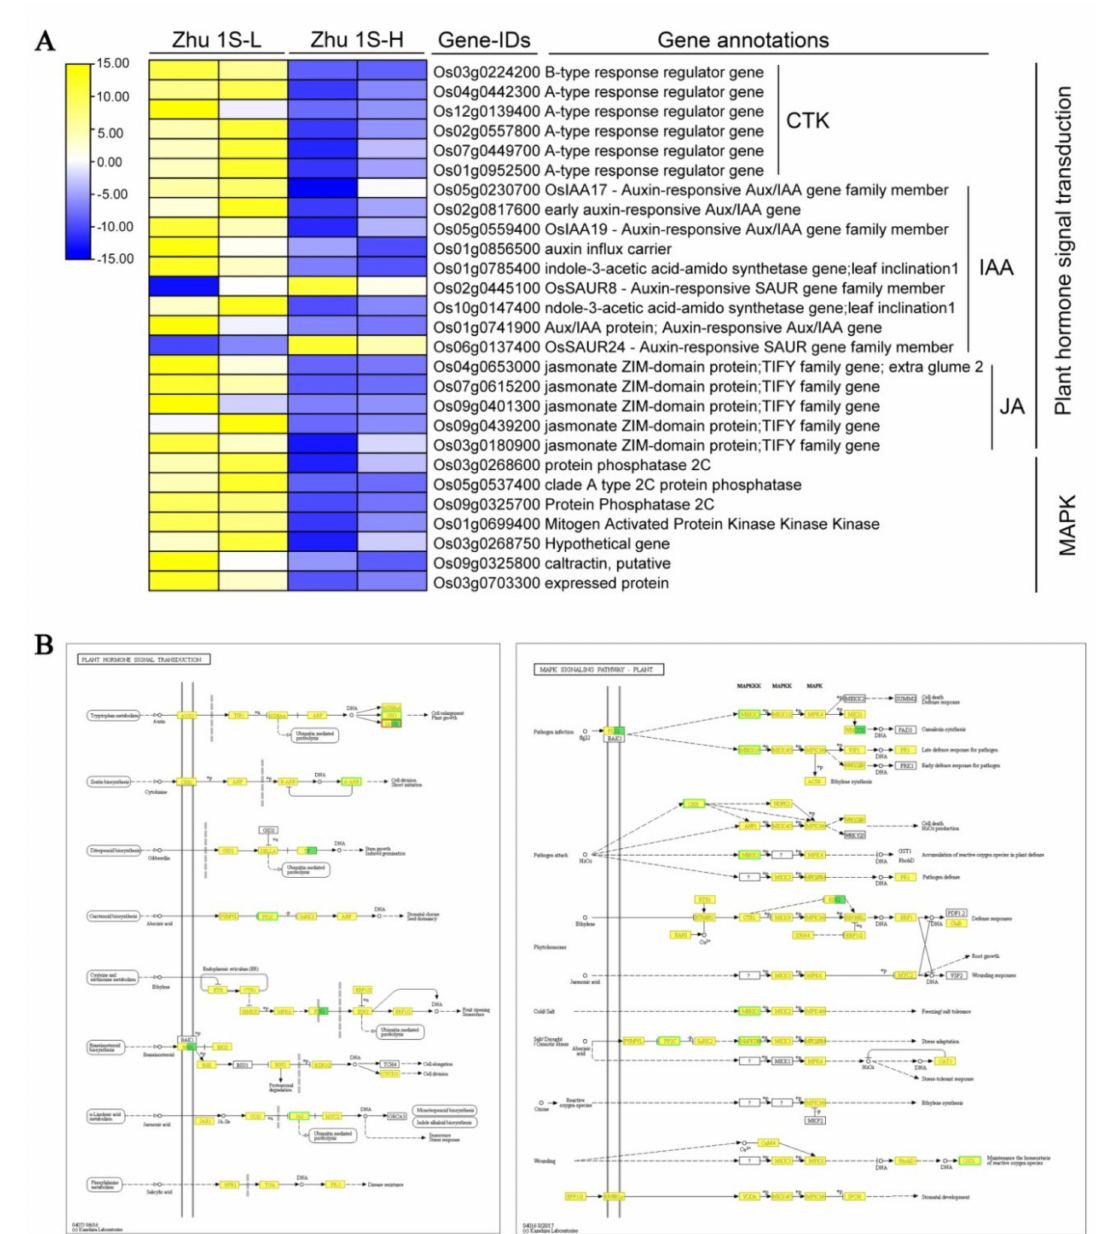
Figure 3. Differentially expressed genes involved in plant hormone and MAPK signal transduc- tion in Zhu 1S under high temperature. ( A ) Heatmap representation of differentially expressed genes involved in the plant hormone and MAPK signal transduction in Zhu 1S under high temper- ature. The yellow and blue colors represent increased and decreased transcript level, respectively. ( B ) Schematic of plant signal transduction affected by high temperature in Zhu 1S. The red and green squares indicate up-regulated and down-regulated signal transduction processes under high temperature, respectively. The signal transduction schema was prepared using the KEGG web service (www.genome.jp/kegg/, 1 January